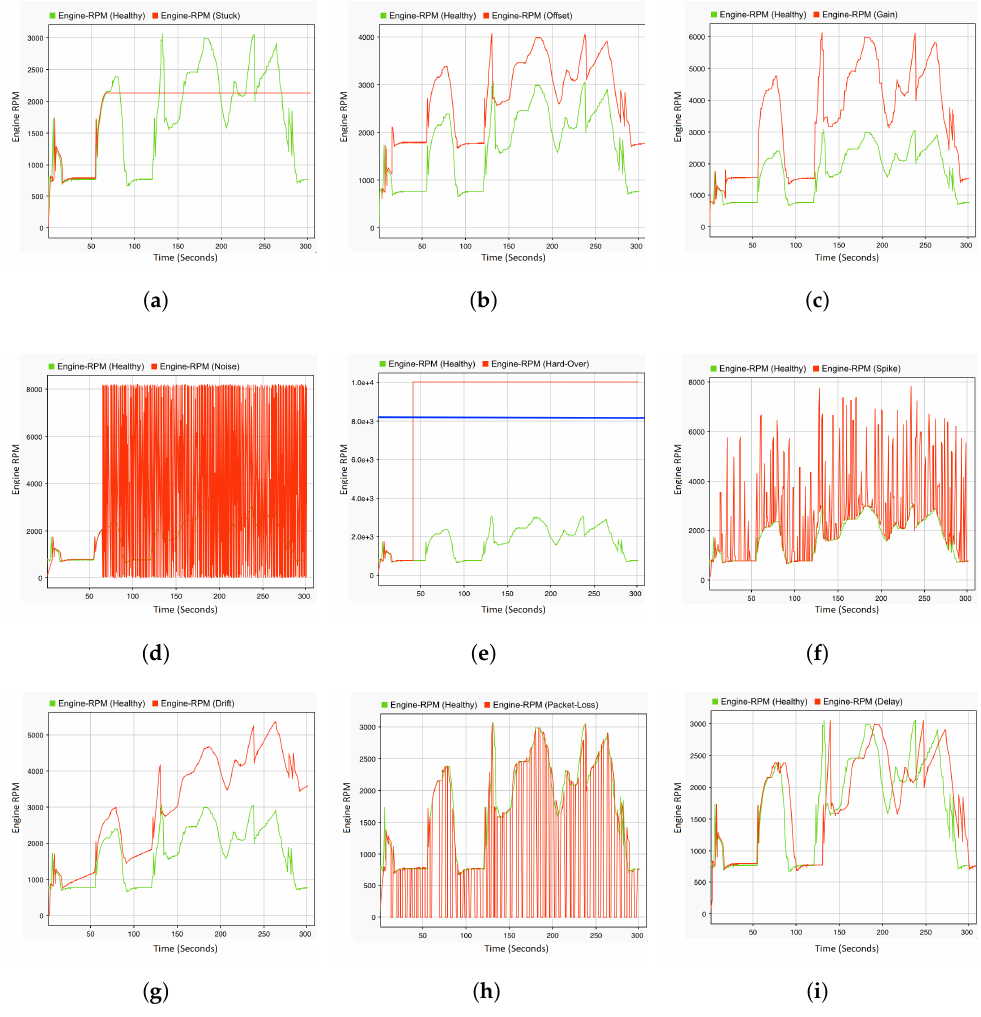
Figure 4. Fault types. ( a ) Stuck-at fault, ( b ) Offset fault, ( c ) Gain fault, ( d ) Noise fault, ( e ) Hard-over fault with maximum threshold, ( f ) Spike fault, ( g ) Drift fault, ( h ) Packet loss fault, ( i ) Delay fault. The FI time at which the fault is to be injected can be defined on the basis of the driving cycle. The duration of the occurrence of the fault can be used to distinguish between permanent/persistent faults and transient faults [63]. Transient faults are short-term